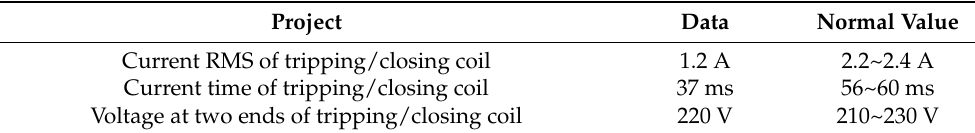
Table 10. Relevant data of CB15.